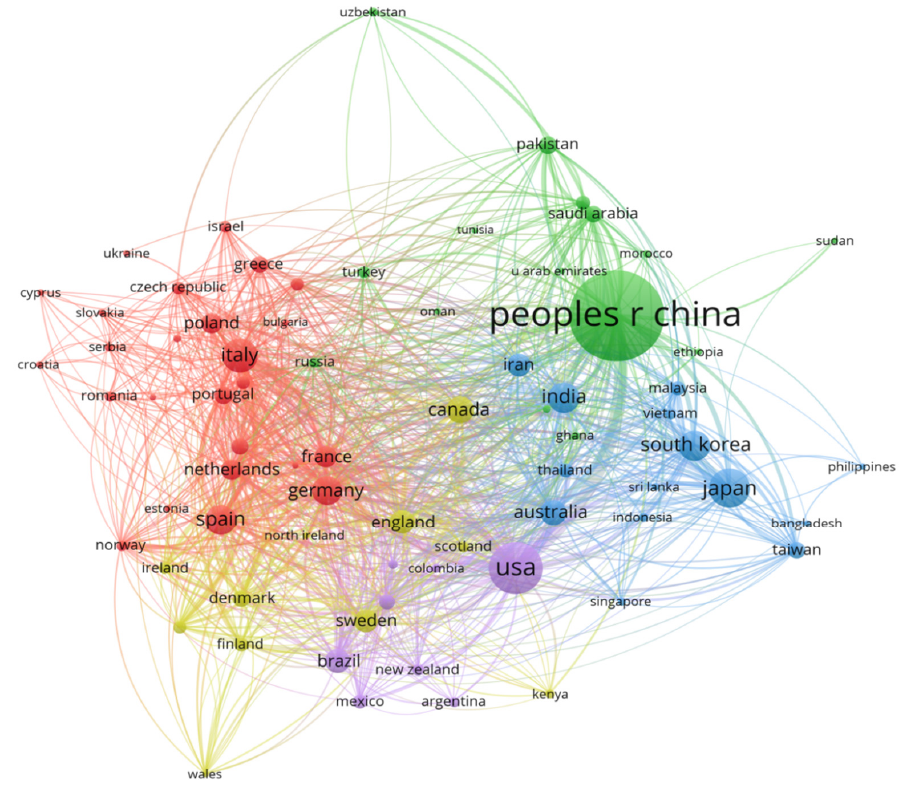
Figure 3. Countries co-occurrence map of CA.